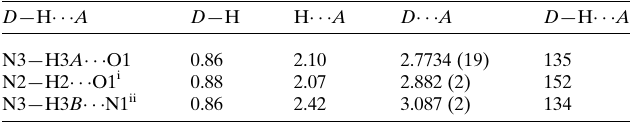
Table 1 Hydrogen-bond geometry (A˚ , (cid:2) ).